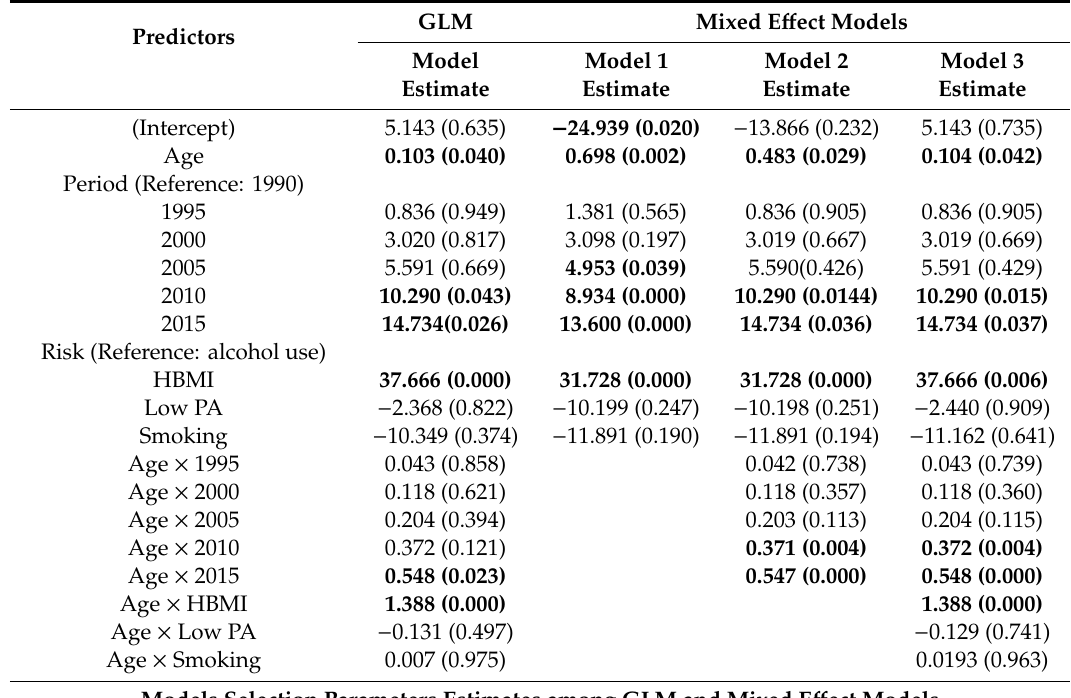
Table 2. GLM and mixed-e ff ect model estimates ( p -value) predicting disability-adjusted life years (DALYs) among Chinese